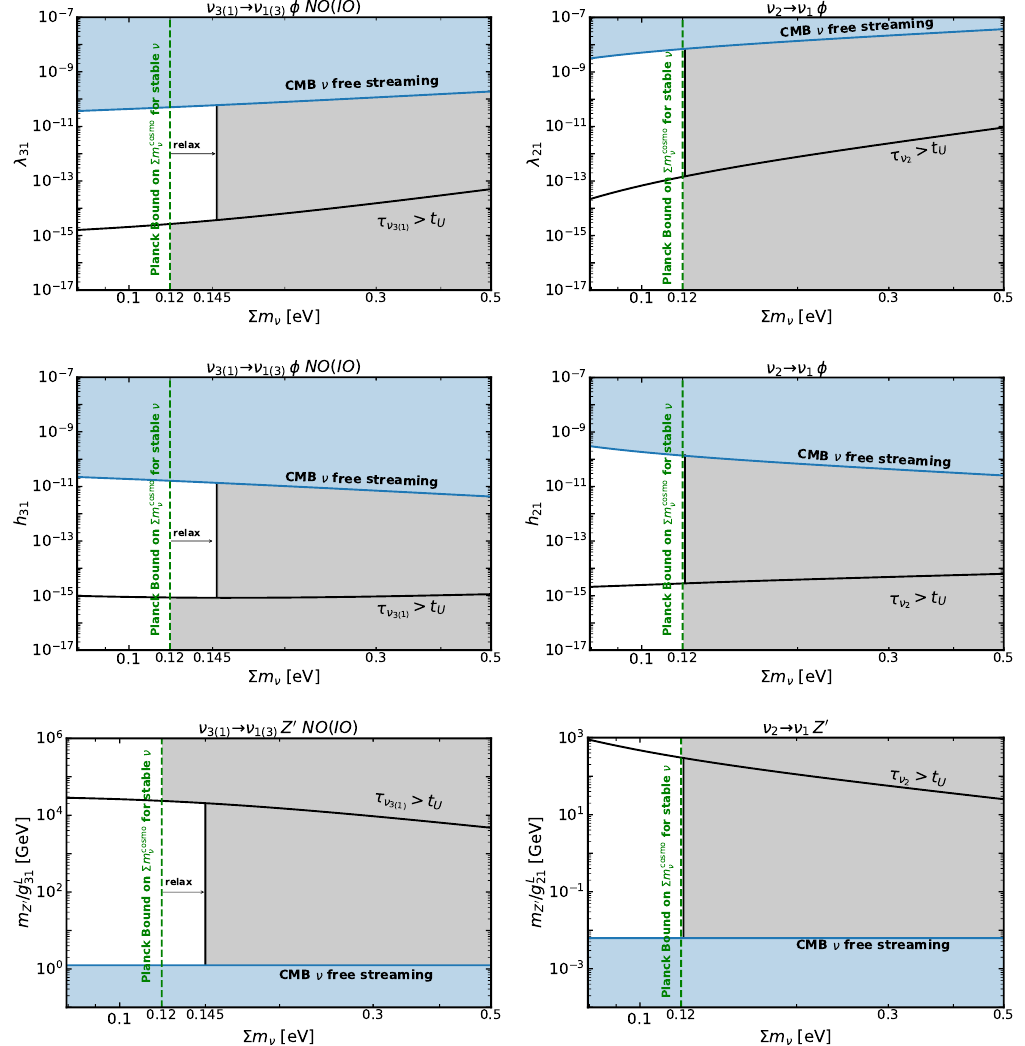
Figure 9 . Parameter space for 2 -body invisible neutrino decays (case 2a in figure 1). Left panel: ν → ν φ/Z 0 decay modes for NO (IO). Right panel: ν 2 → ν 1 φ/Z 0 decays. Note that the figure 3(1) 1(3) for ν → ν φ for NO (IO) are almost identical to the left panels. The upper panels correspond 3(2) 2(3) to neutrino decays via pseudo-scalar couplings, the middle panels correspond to scalar couplings, and the lower panels to neutrino decays with a vector boson in the final state. For concreteness, we have considered m φ , m Z 0 (cid:28) m ν . We highlight in blue the bound on invisible neutrino decays from Planck CMB observations [22] (see section 3.1). In dashed green we highlight the current bound on P m ν within Λ CDM [12], and show with an arrow the extent to which it can be relaxed. We shade in grey regions of parameter space that are be excluded by the current Planck bound P m cosmo < 0 . 12 ν